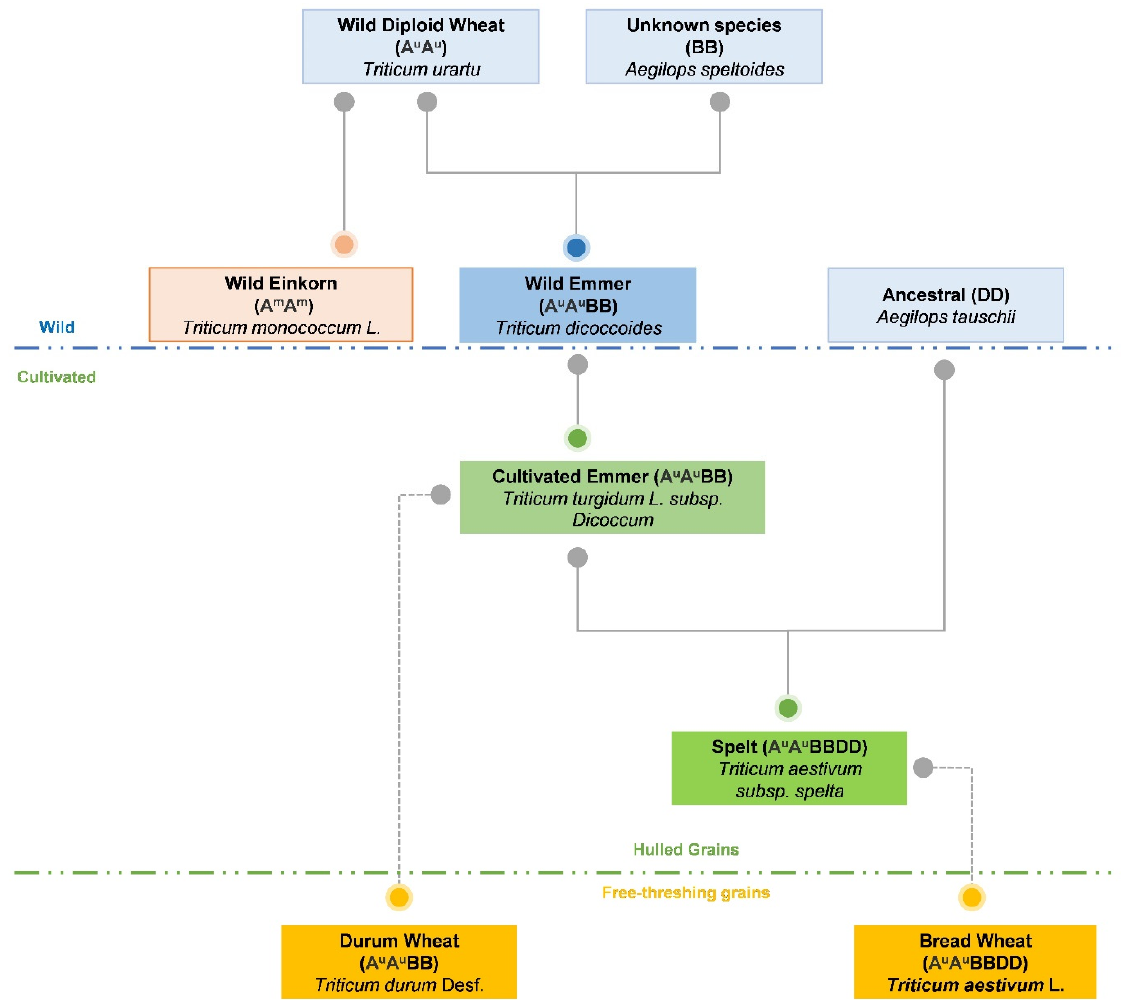
Figure 1. Phylogeny of the domesticated species of durum wheat (Triticum durum Desf.) and common wheat ( Triticum aestivum L.).